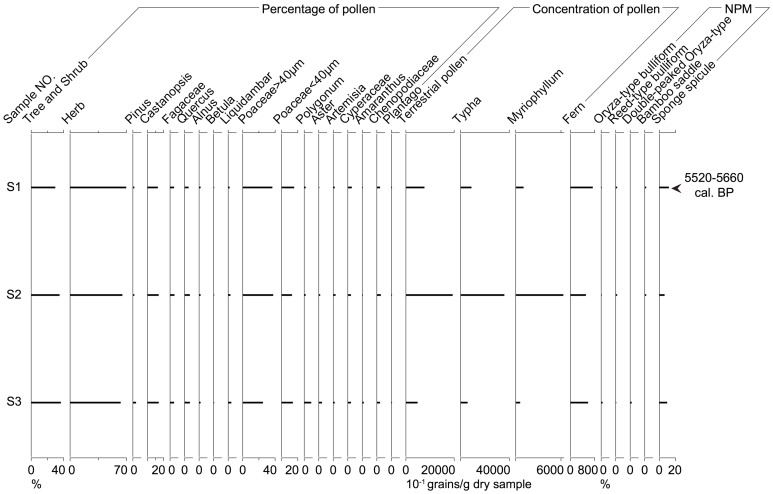
Integrated paleoecological data of rice paddies (S1–S3) from the Jiangli site.